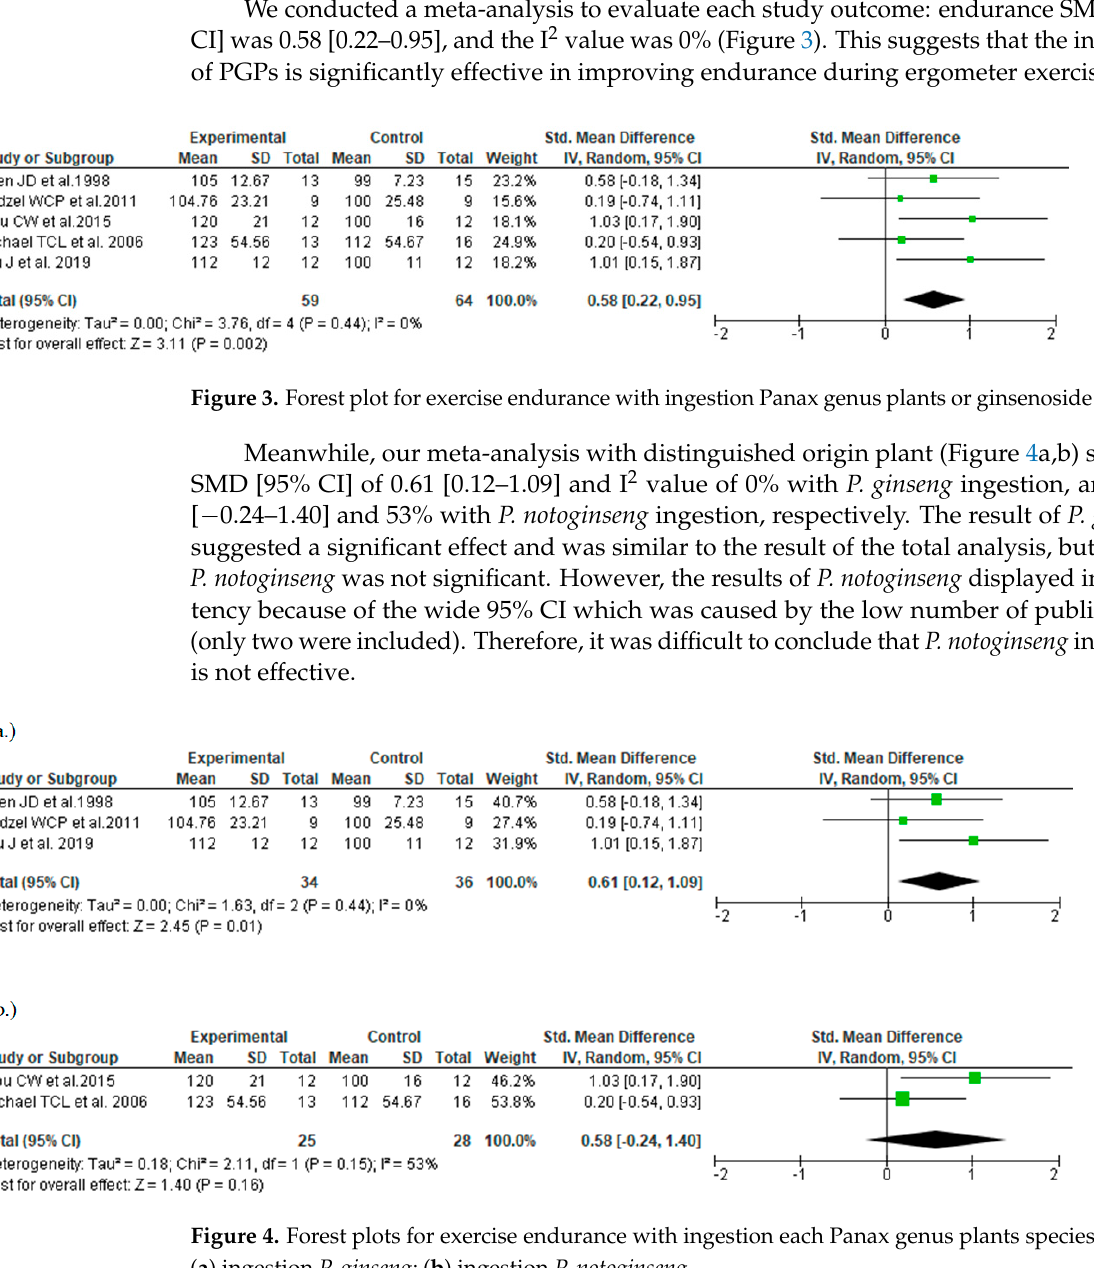
Figure 4. Forest plots for exercise endurance with ingestion each Panax genus plants species [12– 16]. ( a ) ingestion P. ginseng ; ( b ) ingestion P. notoginseng